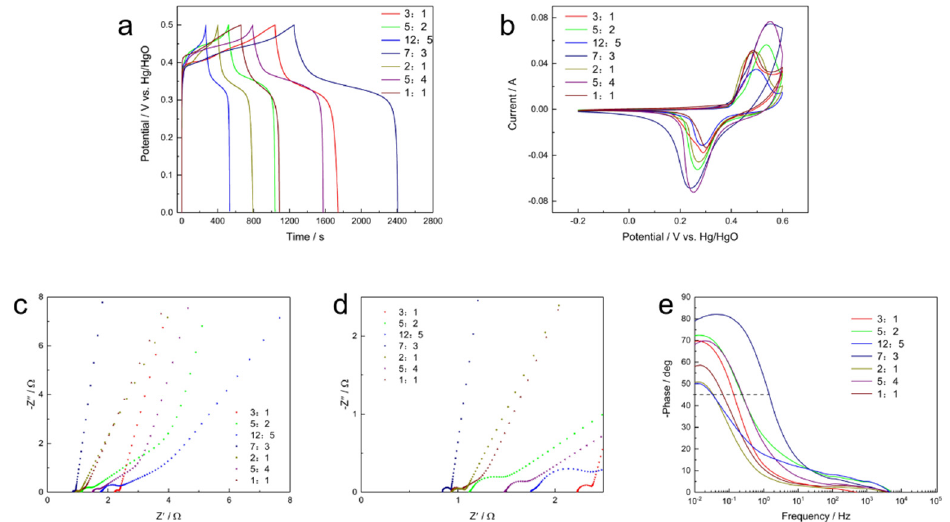
Figure 6. The electrochemical test graphs of various Ni/P ratios. ( a ) Galvanostatic charge-discharge curves of electrodes prepared with various Ni/P ratios at 1 A g − 1 . ( b ) Cyclic voltammetry curves of electrode prepared with various Ni/P ratios at a sweep rate of 3 mV s − 1 . ( c , d ) Nyquist plots of electrodes prepared by various Ni/P ratios. ( e ) Bode plots of electrodes prepared with various Ni/P ratios. Table 1. The electrochemical performance of composites prepared with various raw material ratios. Ratio of Raw (Ni:P)